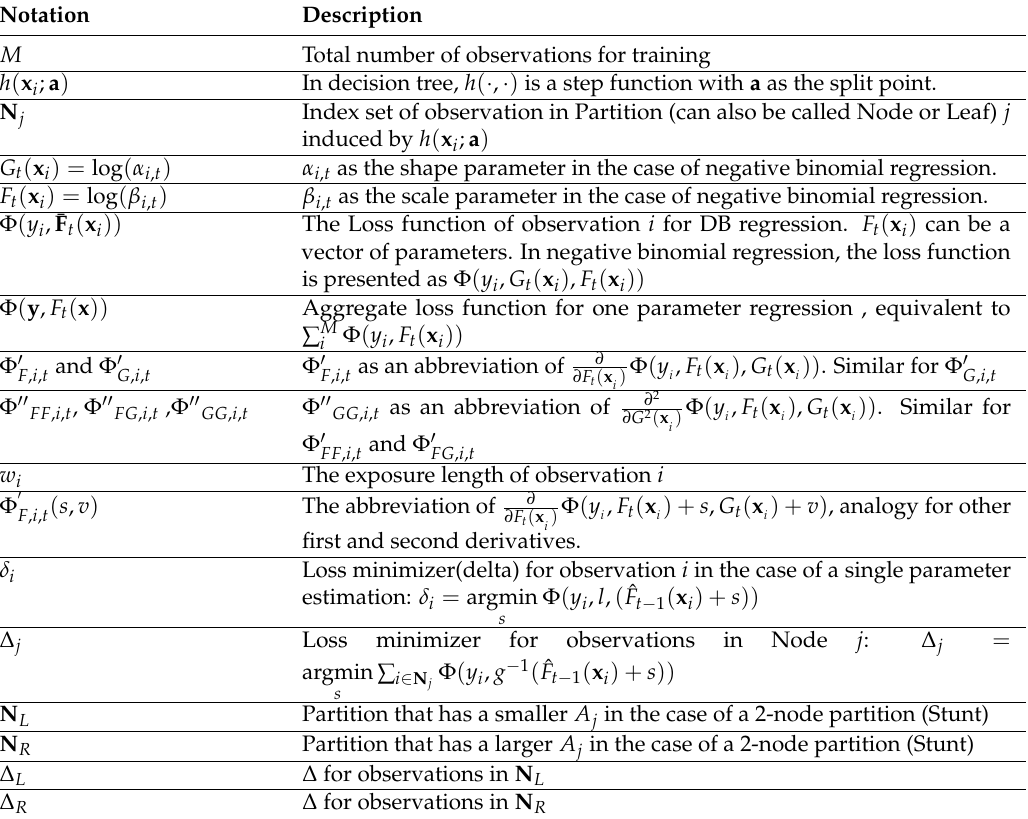
Table 1. Key notation and definitions in this